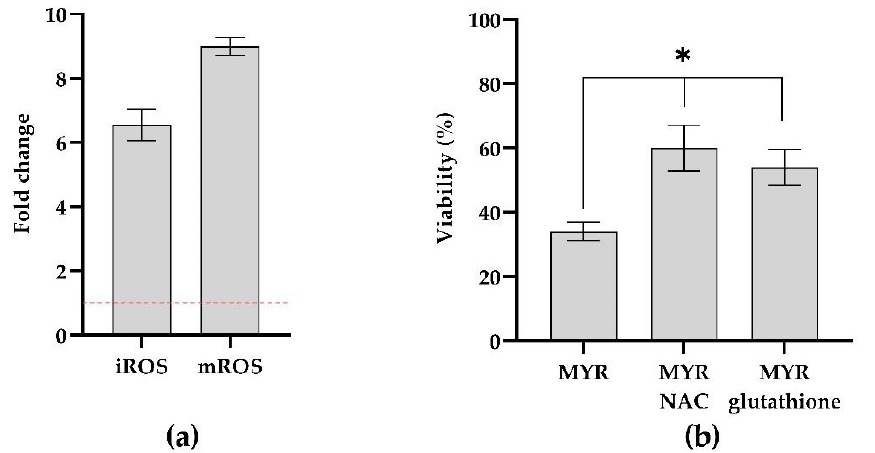
Figure 5. Induction of intracellular and mitochondrial ROS ( a ) and Cell Rescue Assay using ROS scavengers ( b ) on dual-species biofilm of C. auris and K. pneumoniae using MYR at the concentration of 12.5 μg mL −1 . * = p < 0.05 (Dunnett’s test).